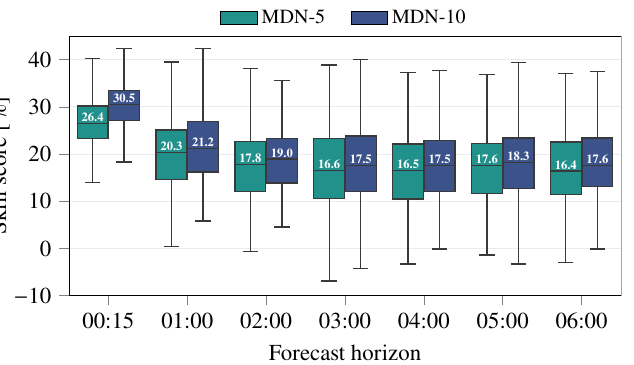
Figure 5. Forecast quality of the MDN depending on the forecast horizon for different numbers of mixture distributions of 182 days of training data. The forecast quality of the MDN with a single output distribution serves in each case as a reference value for the skill score. Consequently, the values represent the percentage improvement of the forecast quality caused by the additional used mixture